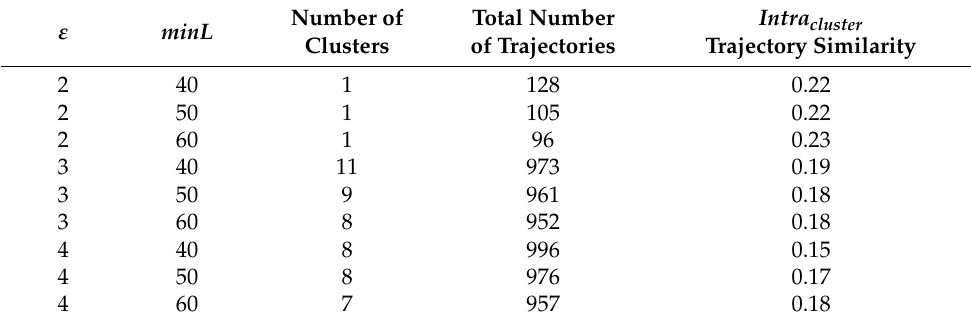
Table 10. DBSCAN clustering results.